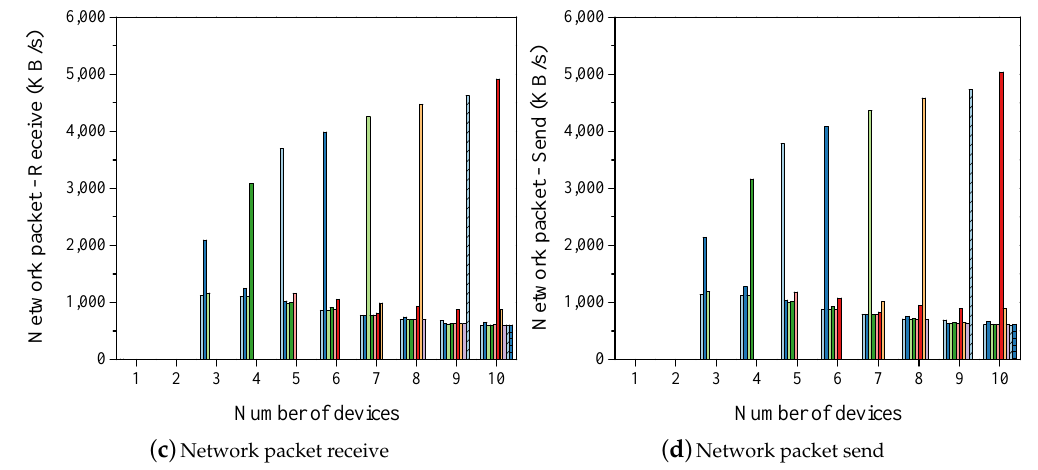
Figure 4. Hardware resources for training LeNet (CNN).